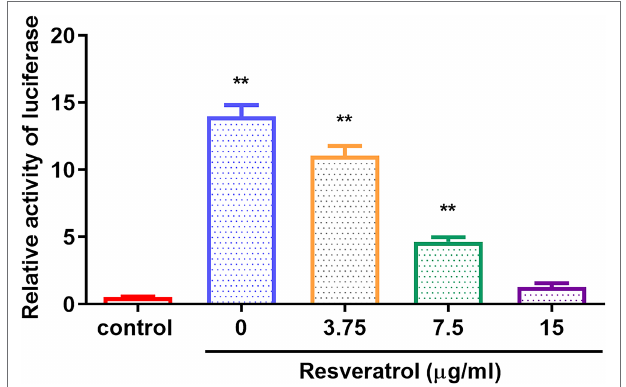
FIGURE 4 | The effects of Res on transcriptional activation of IE180 protein by dual-luciferase assay. The 293 T cells were co-transfected with the effector plasmid pcDNA3.1(+) or pIE180, the reporter plasmid pGL3-TK, and the internal control plasmid pRL-TK. After incubation for 24 h, the Res was added to the plate to treat for 48 h, and relative luciferase activity was measured ( n = 3). ** p < 0.01 vs. control group.